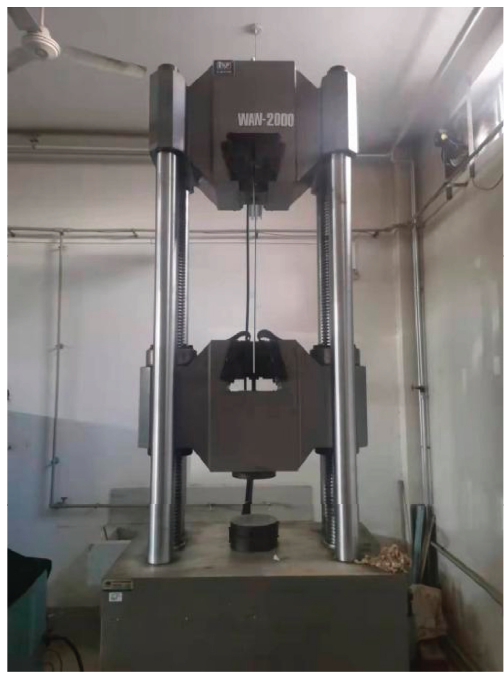
Figure 4: Specimen loading